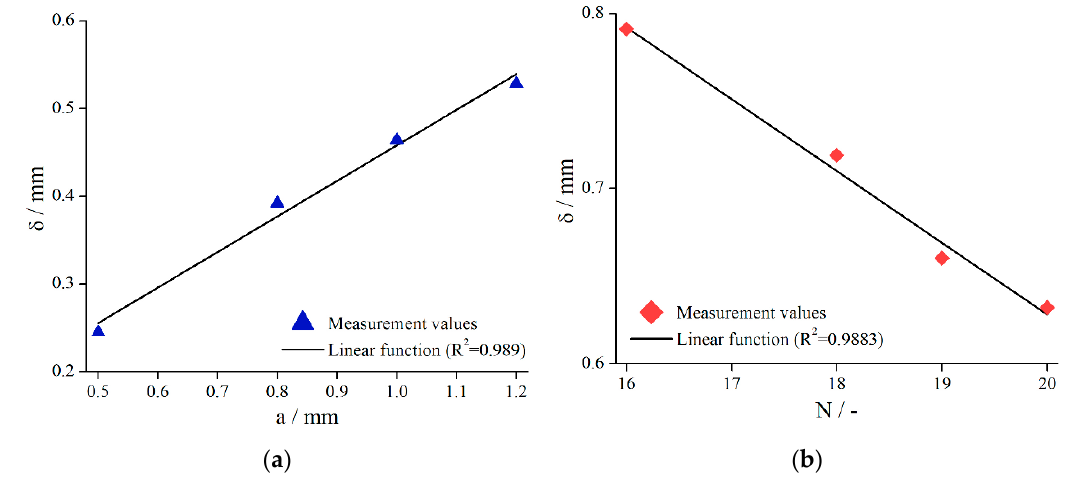
Figure 11. Effective gap extension δ (gap- and material-averaged) dependent on column distance (a) (systems 6–9, 𝐿 = 0.5 mm ) and number of bars (b) (systems 15–18, 𝐿 = 1.0 mm ) for γ (cid:4662) = 5 s −1 .